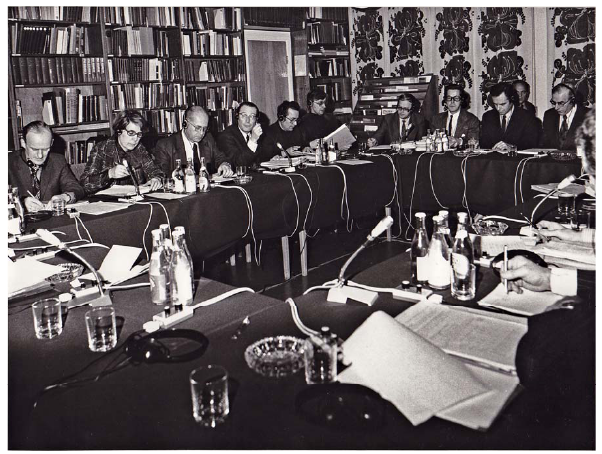
Figure 1. The Council meeting was held in the library of KGI, which was the largest meeting room available but just large enough. The picture was taken from the side of the Chairman near the main entrance door by KGI’s photographer. Only about half of the council members can be seen.